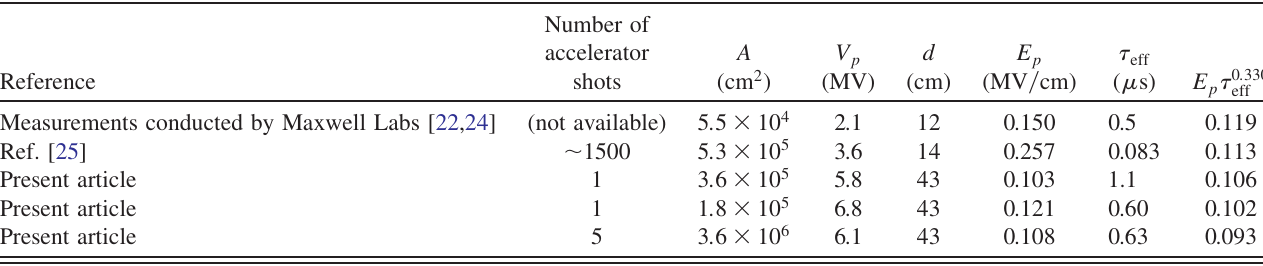
TABLE I. Conditions under which dielectric breakdown of water is observed not to occur. Each of these five observations was made on a large-area ( A (cid:6) 10 4 cm 2 ) water-insulated system with a nominally uniform electric field. The quantity V p is the peak voltage difference between the anode and cathode, d is the minimum distance between the electrodes, E p (cid:4) V p =d , and (cid:2) eff is the temporal width of the voltage pulse at 63% of peak. The last column assumes E p is expressed in MV = cm , and (cid:2) eff in (cid:1) s . The Maxwell-Lab measurements were performed on a capacitor with coaxial electrodes that had outer and inner radii of 60 and 48 cm, respectively [22,24]. The peak field E p given for the Maxwell measurements is that at the outer conductor (which was the anode), and is corrected for the coaxial geometry. The peak fields of the tests described in the present article are similarly corrected. The observations summarized in the table are consistent with the design criterion given by Eq.